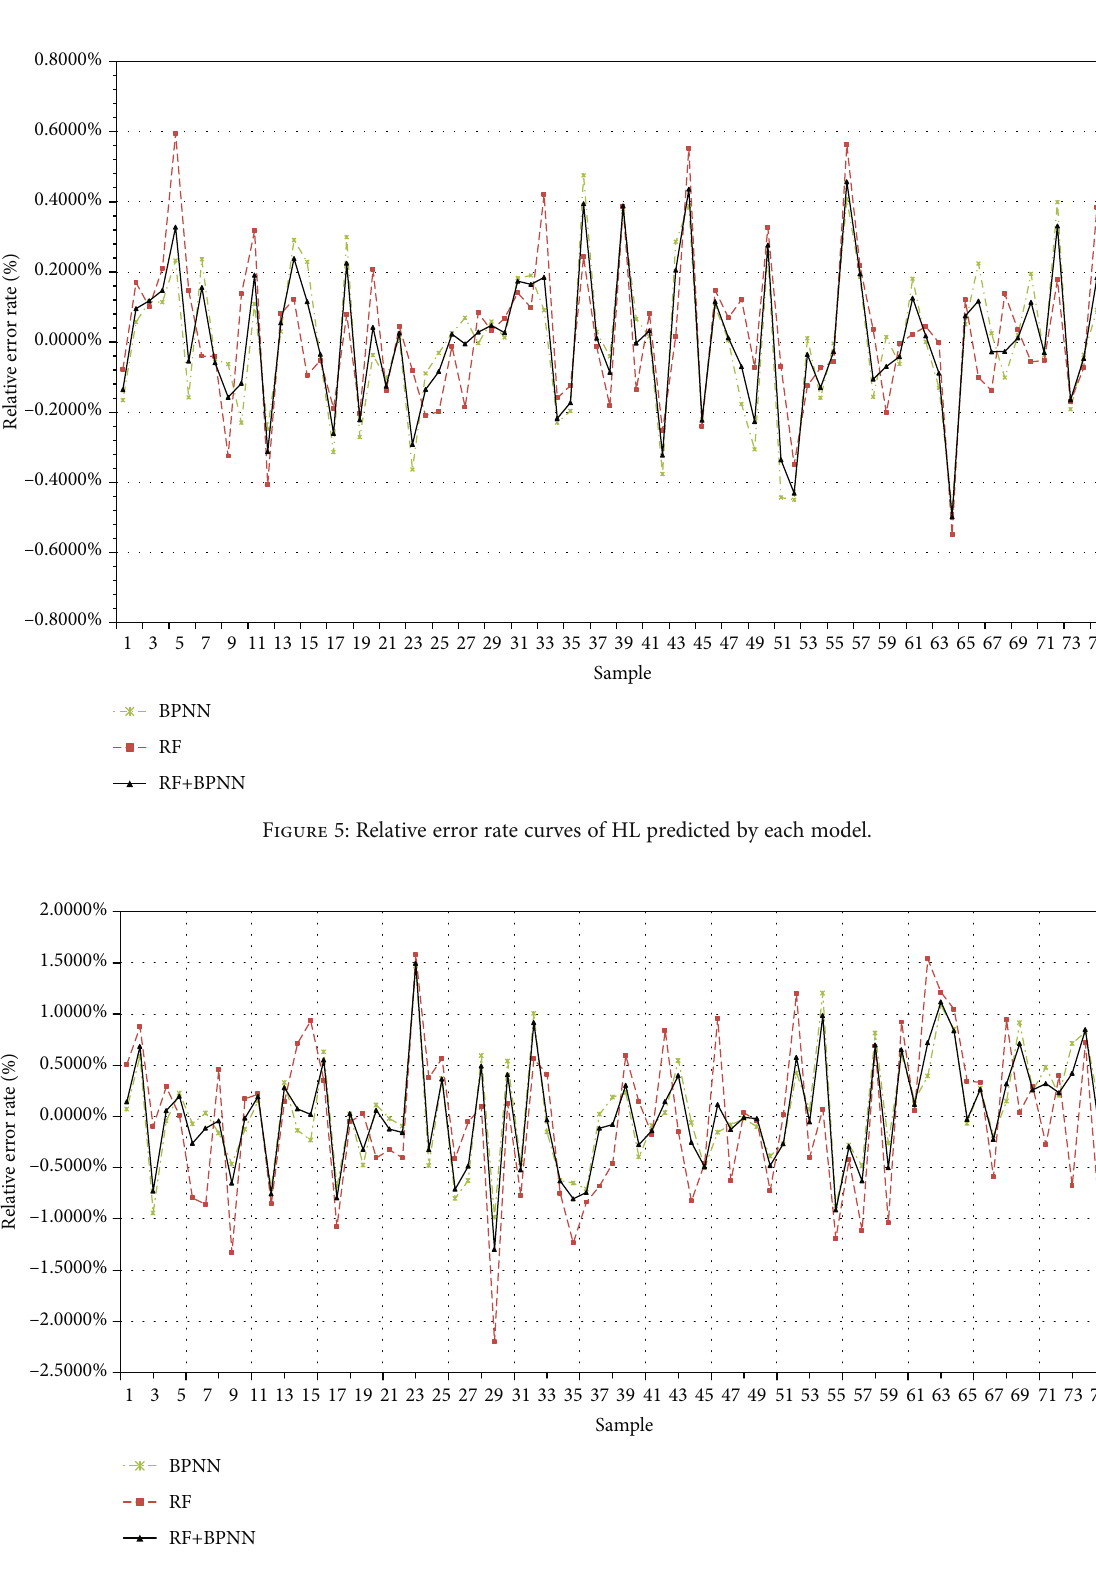
Figure 6: Relative error rate curves of CL predicted by each